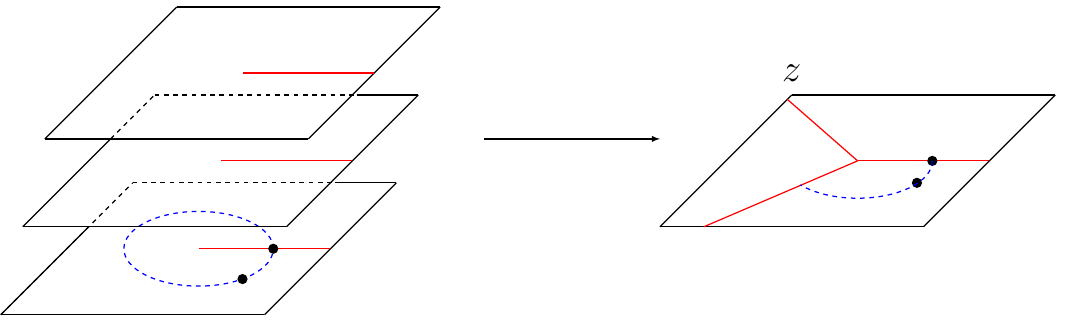
1 /n maps the n -sheeted manifold to the complex 1 Figure 3 . The coordinate transformation z = Z